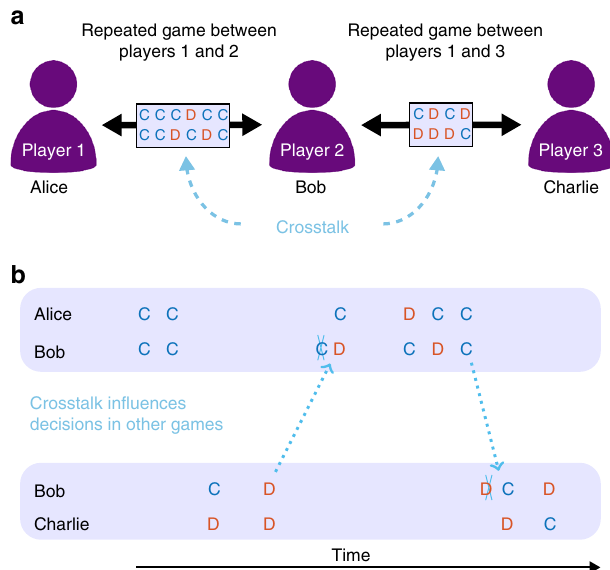
Fig. 1 Crosstalk between repeated games. a Bob is engaged simultaneously in independent, repeated games with Alice and Charlie. Crosstalk means that the moves that occur between Alice and Bob can affect Bob ’ s decisions towards Charlie. b Alice and Bob as well as Bob and Charlie simultaneously play a repeated Prisoner ’ s Dilemma. The rounds of the two games occur at particular times. In each round the players can either cooperate (C) or defect (D). The outcome of a round in one game can in fl uence the subsequent round in the other game. Crosstalk is indicated by dotted arrows